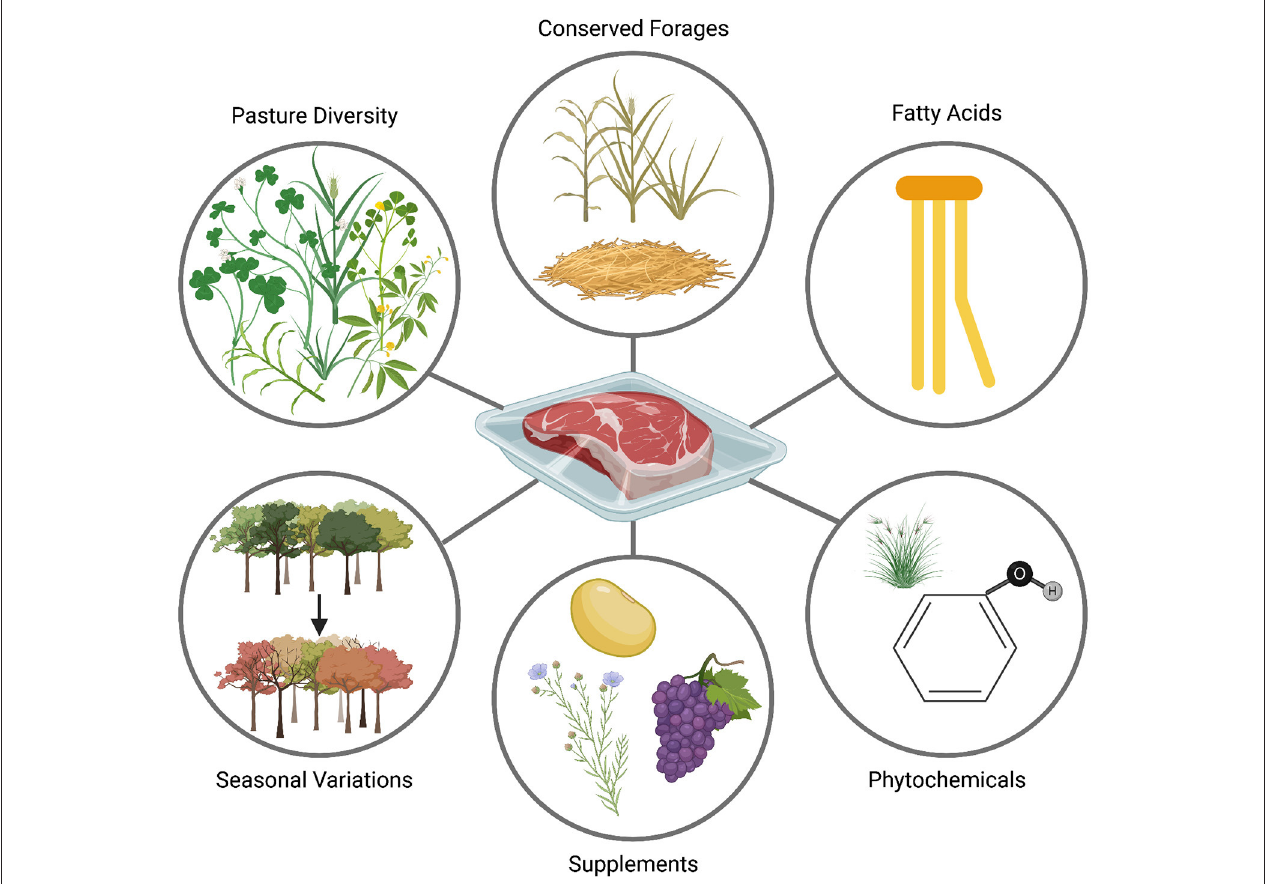
FIGURE 1 | The effects of pasture diversity, seasonal variations, feed conservation, and supplementation on phytochemicals and fatty acids of beef. Cattle finished in different seasons exhibit different fatty acid profiles and phytochemical content. Supplementing cattle diets with flaxseed, algae, or other conserved forages can also affect the nutritional quality of beef. Created with